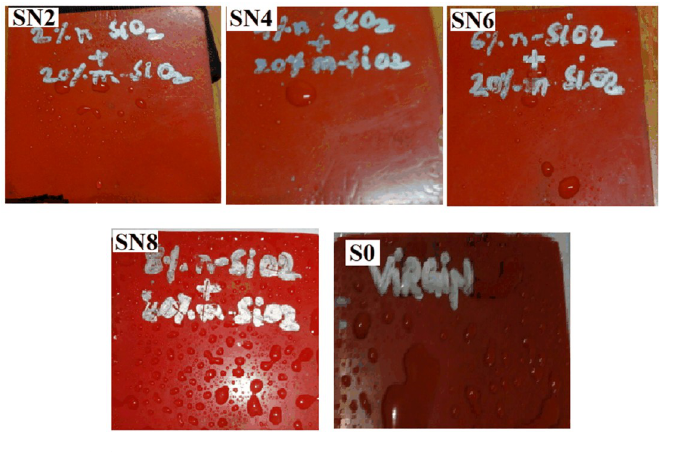
Fig 7. HC before